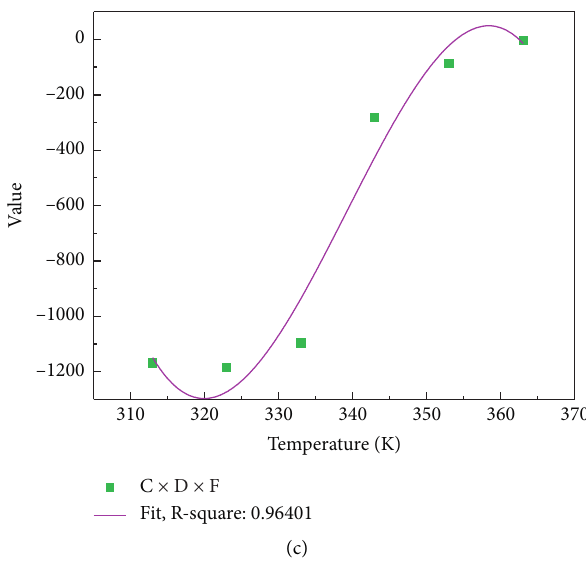
Figure 7: Fitting result of C , F , and C × D × F at different temperatures. (a) C , (b) F , and (c) C × D × F .